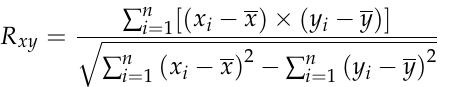
Figure 3. Correlation distribution of monthly average values in Yunnan Province from 2009 to 2011: ( a ) sc_PDSI & SIF; ( b ) sc_PDSI & EVI; ( c ) sc_PDSI & NDVI. (The numbers below the title are the range of values for this raster plot and the mean value).